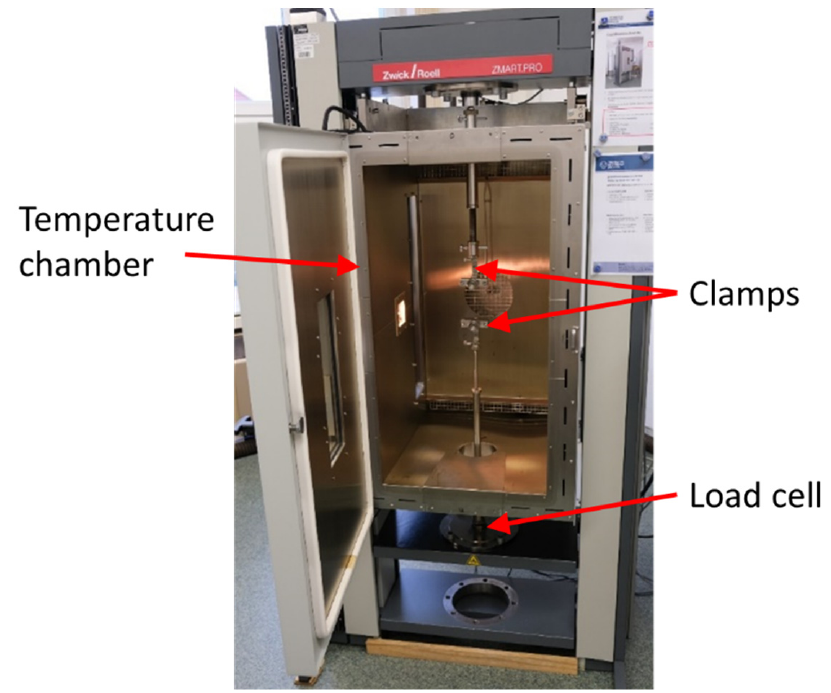
Figure 7. Zmart.Pro tensile testing machine with a connected temperature chamber.